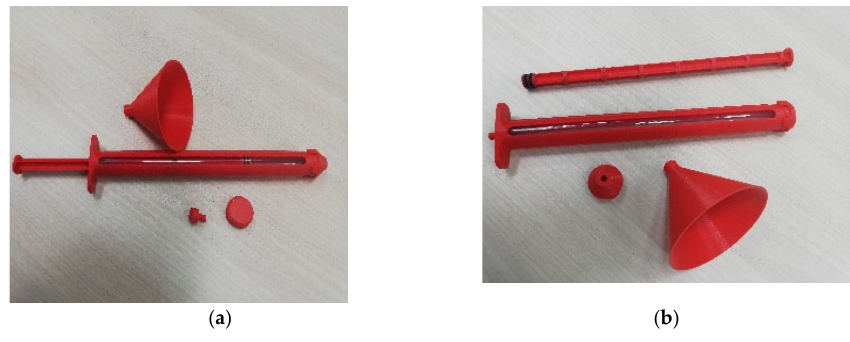
Figure 5. The alternative prepared for dosing ( a ) and transport ( b ).